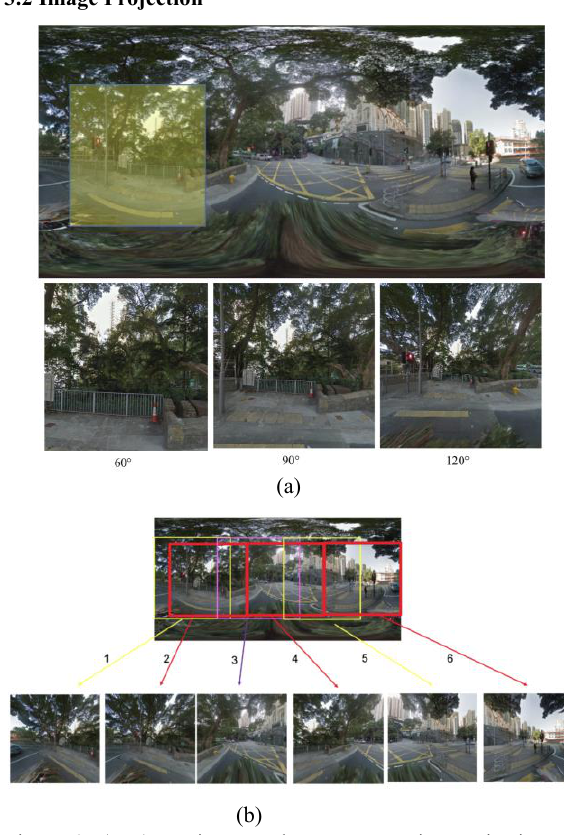
Figure 3. (Top) Equirectangular to perspective projection at different field of view (FOV). Yellow box is an area to carry out the projection. (Bottom) The equirectangular image is exported into 6 perspective images (FOV 114°) for CNNs training The format for GSV image is in equirectangular projection which is unwrapped from spherical format. Equirectangular image is a common format used by panorama camera